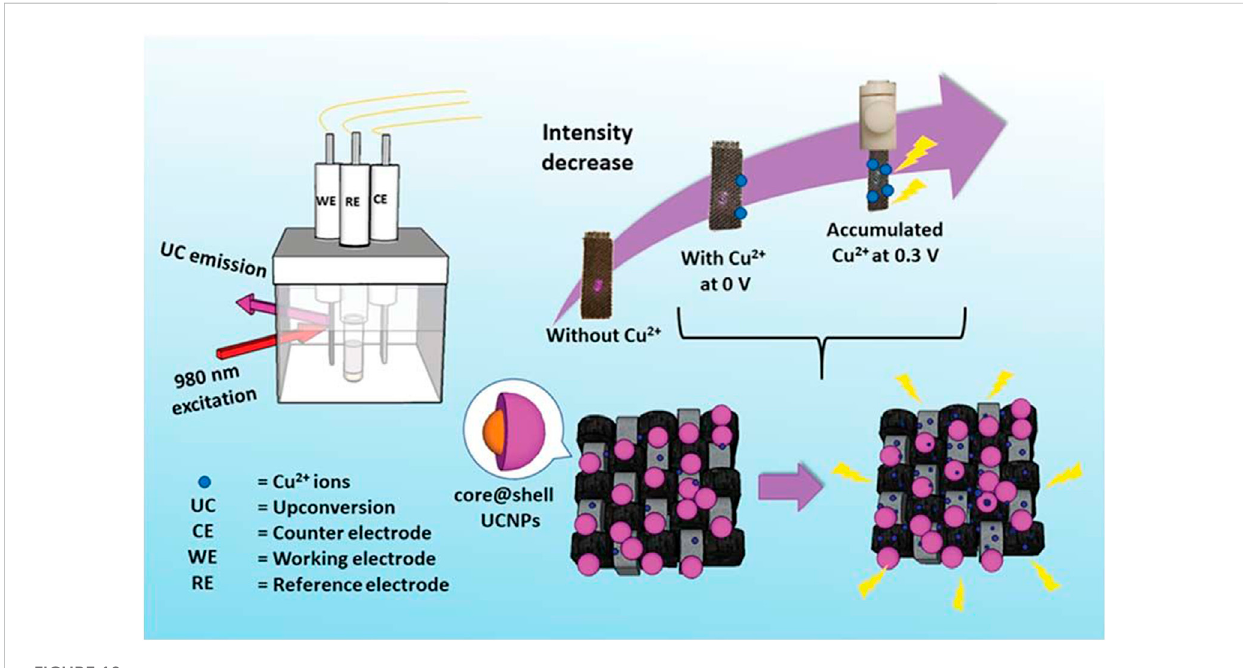
FIGURE 10 AschematicdiagramshowingtheCFC-Ln-UCNPsprobeforCu 2+ ionsensingwithelectrochemicalassistance.[ReprintedwithpermissionfromRef. (Wong et al., 2019) Copyright 2019: Royal Society of